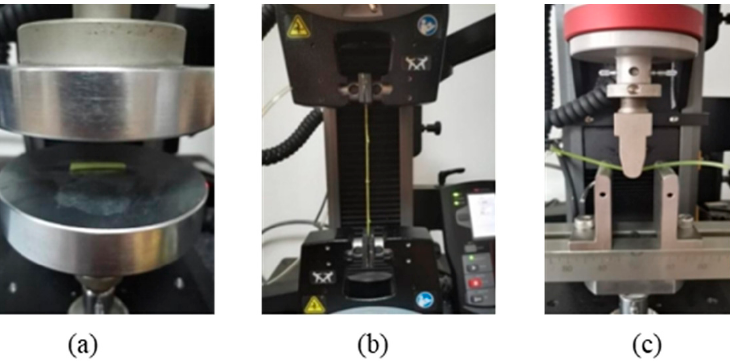
Figure 3. Test hairy vetch steam. ( a ) Radial compression test; ( b ) Axial tensile test ; ( c ) Radial bend- ing test.